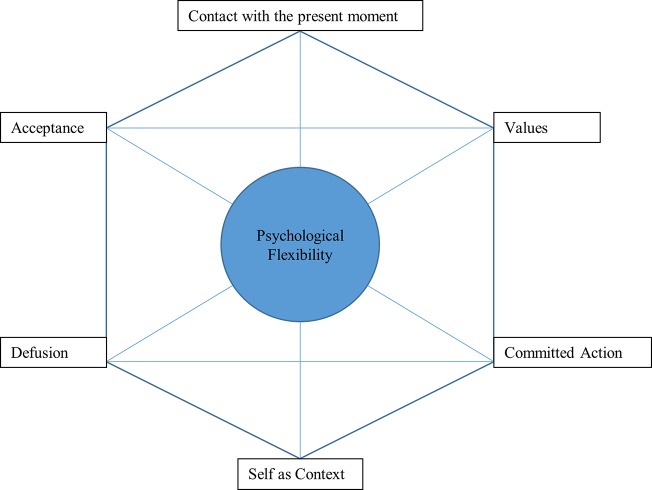
Prepared by the authors based on Hayes et al. (2006), p. 25.